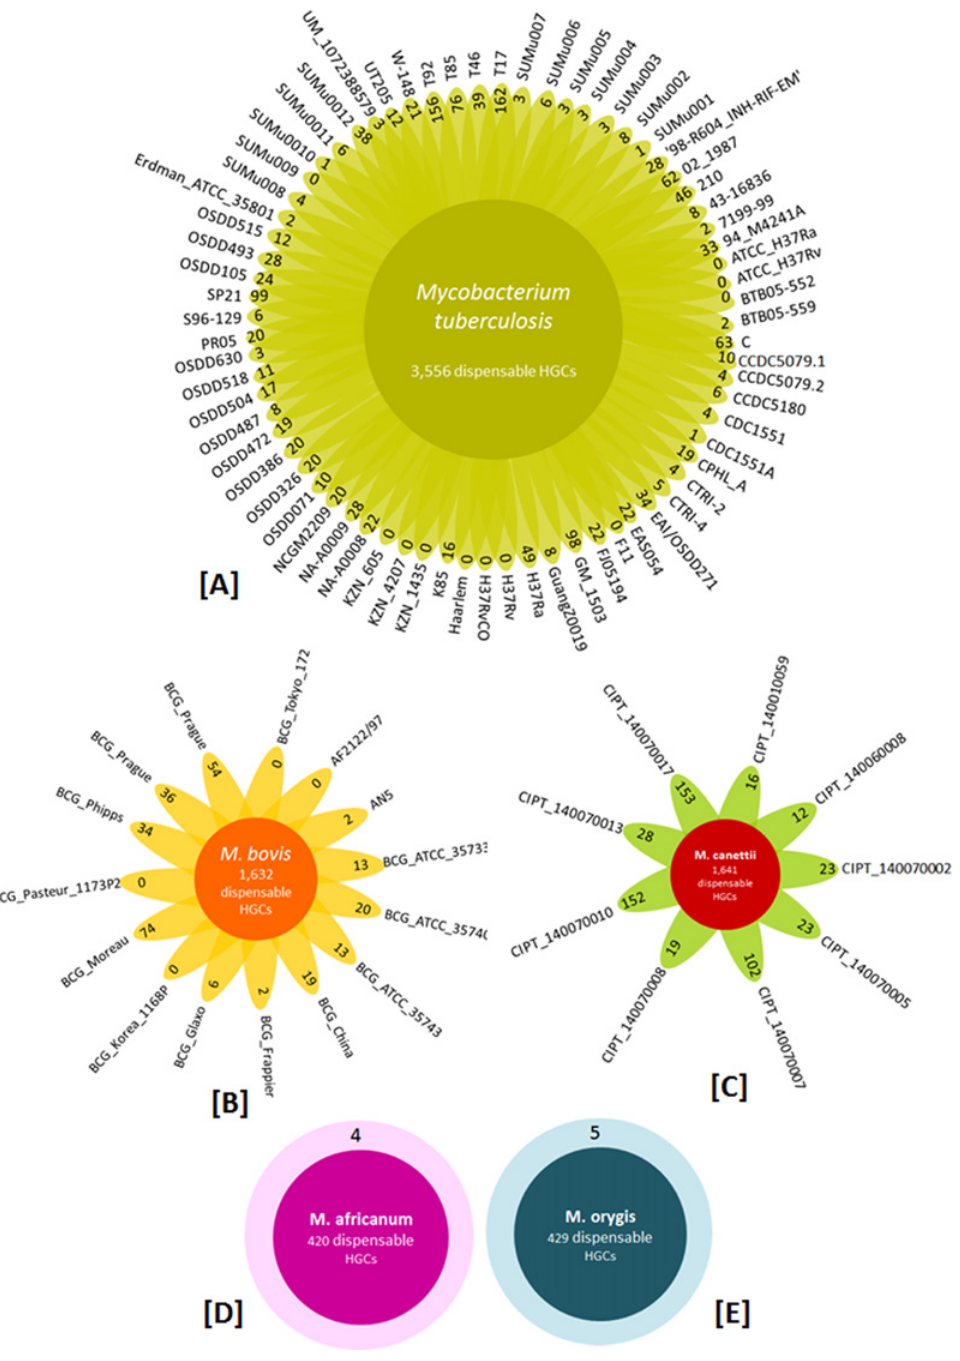
Fig 5. The accessory genome of MTBC. The flower plots depict the distribution of accessory genome HGCs across different species of MTBC. (A) Flower plot showing number of accessory HGCs present in Mtb (in center) and number of species-specific genes in the leaves. (B) Number of species-specific genes of M . bovis in leaves and total accessory HGCs in center. (C) M . canettii has accessory HGCs in center and species-specific genes in leaves. (D and E) The genomes of M . africanum and M . orygis have four and five species-specific genes respectively (outer circle) and total accessory HGCs in the center.